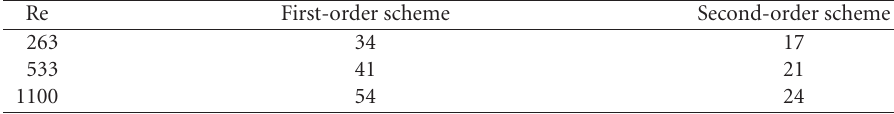
Table 3.1. Number of iterations for the first- and second-order schemes.